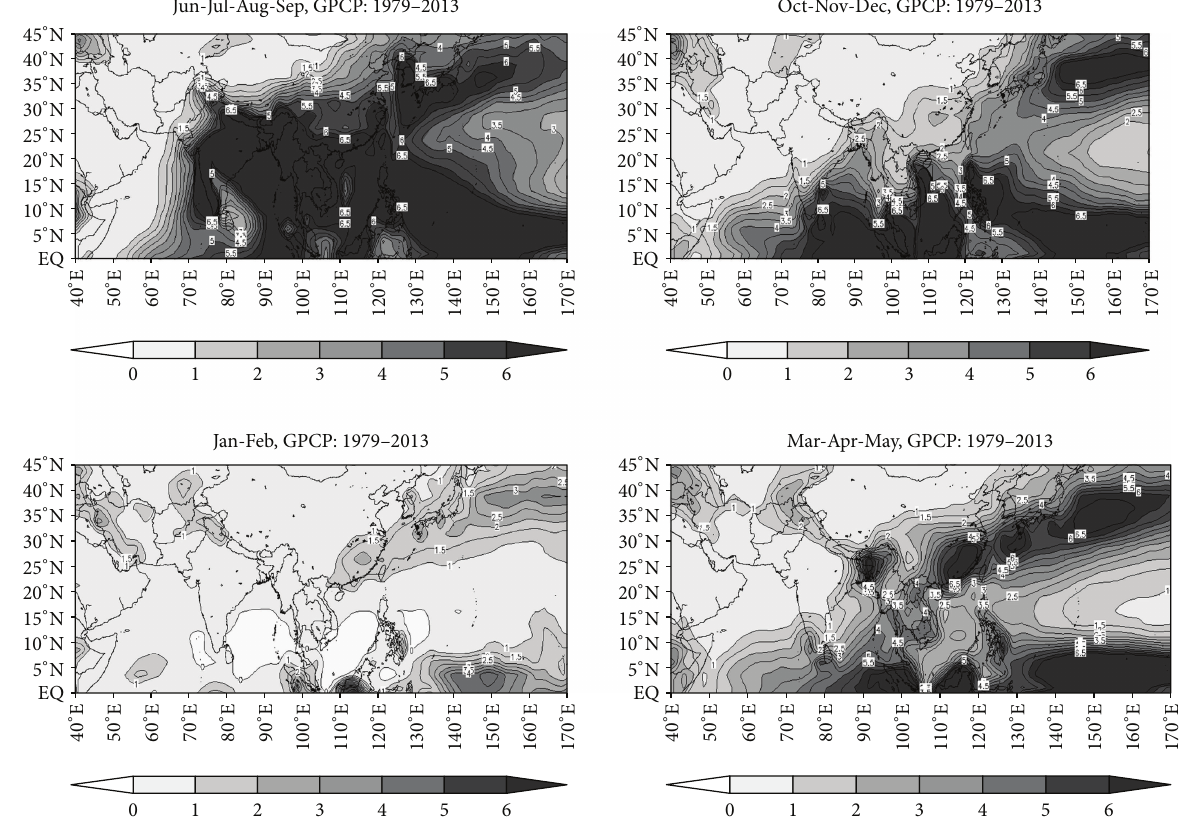
Figure 4: Seasonal climatology of monthly average